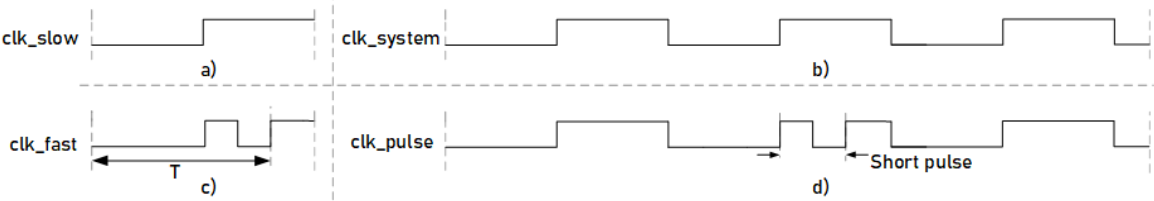
Figure 8. Representation of the waveforms generated to setup the short pulse insertion. ( a ) One period of the slow clk; ( b ) continued use of the slow clk waveform to perform the system clk; ( c ) one period of the fast clk; ( d ) combination of the system clk and fast clk to obtain the short pulse in the system clk.